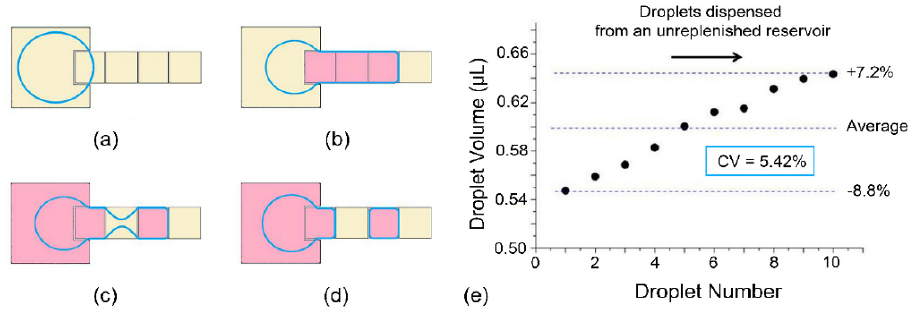
Figure 2. Droplet dispensing in traditional EWOD devices. ( a – d ) Schematic of the dispensing process. The blue contour demonstrates the shape of the liquid. The pink electrodes are applied to the actuation voltage, while the yellow ones are grounded. ( e ) Volume of droplets dispensed successively in traditional EWOD devices. Each dot is averaged over 5 measurements, and error bars are not shown for visual clarity.